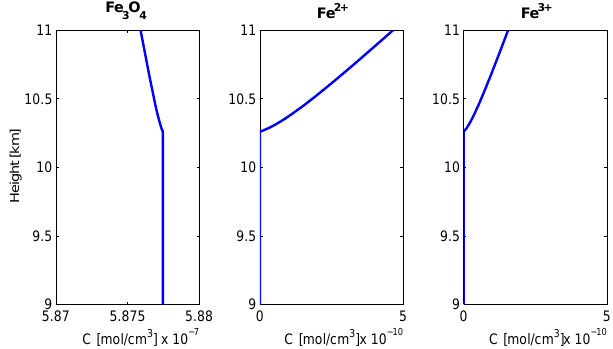
Figure 7. Correlation between pH, HCl content of the magmatic gas and the ash dissolution